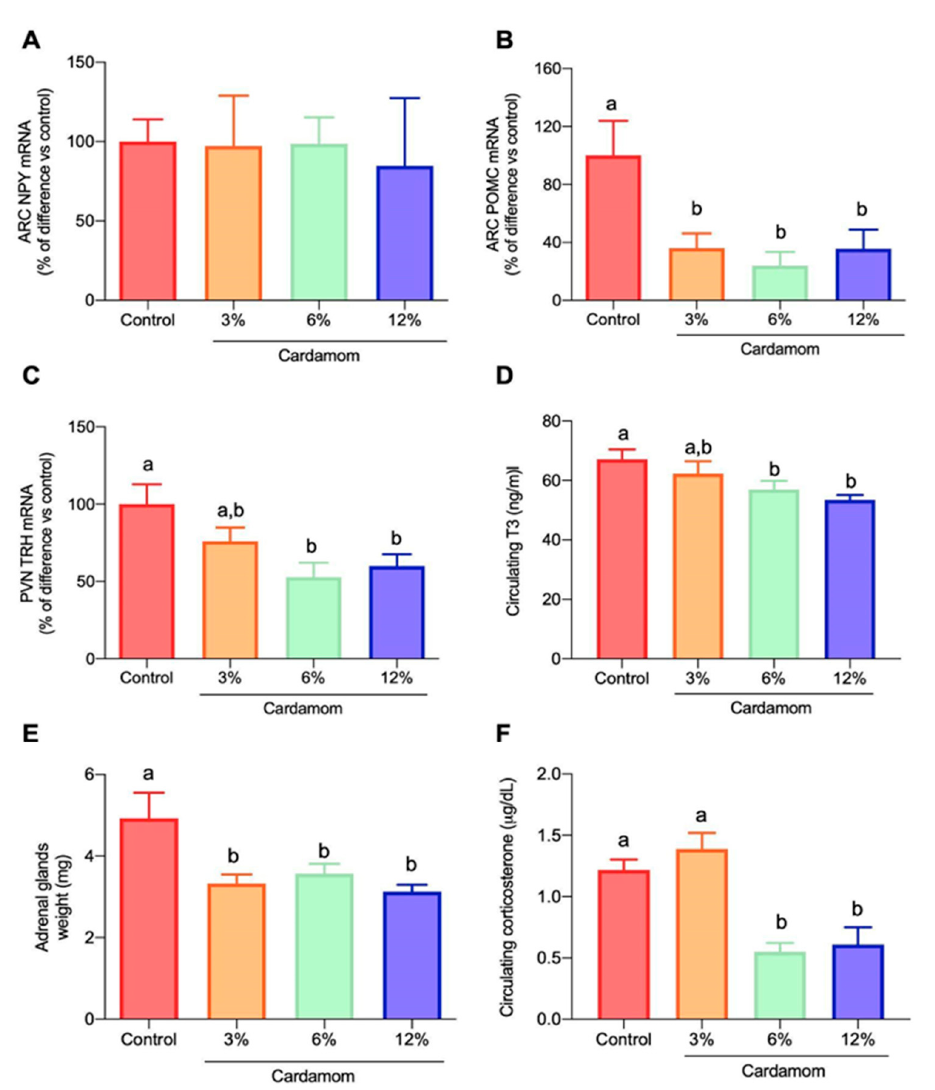
Figure 7. Hypothalamic peptide gene expression and circulating triiodothyronine (T 3 ) and corti- costerone concentration of mice fed a control diet or a diet containing 3%, 6% or 12% of Elettaria cardamomum (EC). ( A ) ARC NPY mRNA and ( B ) ARC POMC mRNA content, ( C ) PVN TRH mRNA expression, ( D ) circulating T 3 levels, ( E ) adrenal glands’ weight and ( F ) circulating corticosterone content in mice fed a control diet or a diet containing different concentrations of EC (3%, 6% or 12%) for 14 weeks. Results are presented as the mean ± S.E.M., n =4–8 mice per group. Mean values with different lowercase letters show statistical differences between each other. One-way ANOVA showed a significant effect of diet: ( B ) F (3,15) = 5.218, p < 0.05, ( C ) F (3,26) = 4.398, p < 0.05, and ( E ) F (3,22) = 6.335, p < 0.01.